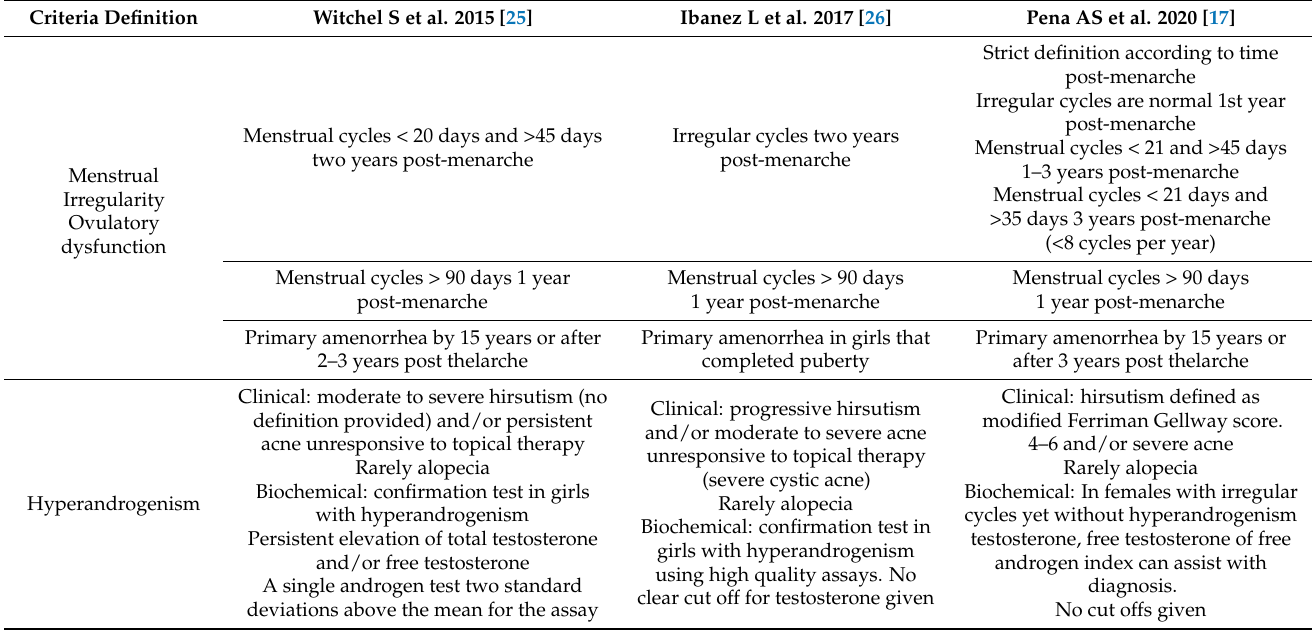
Table 1. Current specific consensus/guidelines criteria for diagnosis of PCOS during